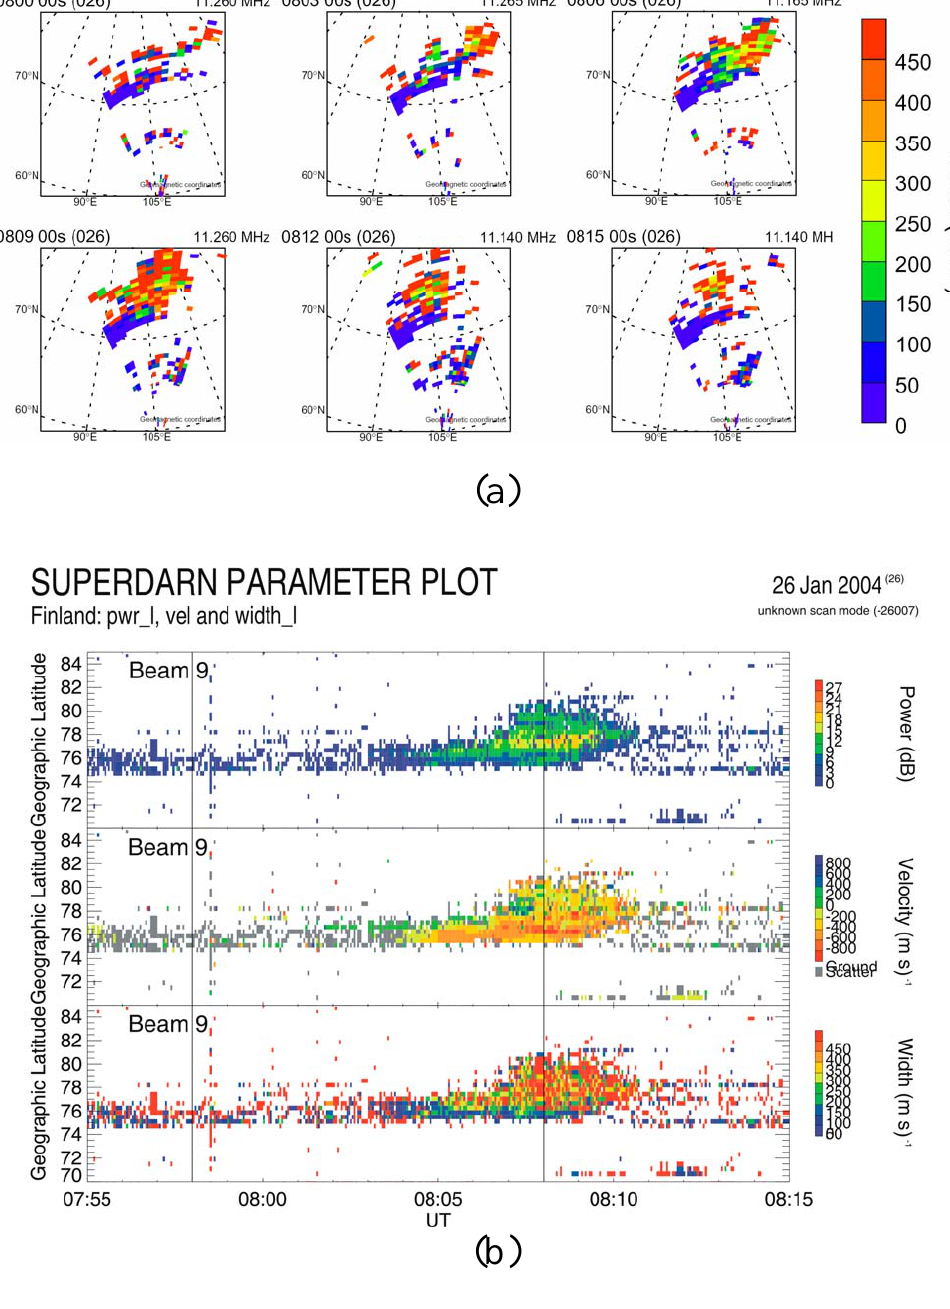
Fig.5. (a) Passage of ionospheric irregularity through the CUTLASS field of view. Fig. 5. (a) Passage of ionospheric irregularities through the CUTLASS field of view (b) Data from beam 9 of the radar. The interval of positive B z is indicated with vertical (b) Data from beam 9 of the radar. The interval of positive Bz is indicated with vertical lines.